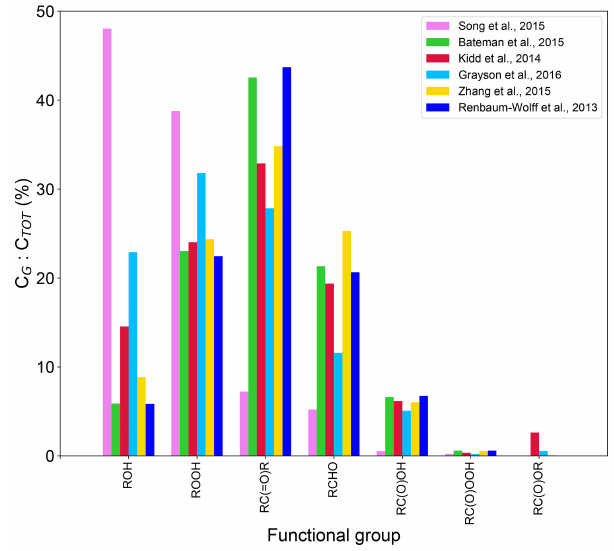
Figure 5. Simulated functional group distributions in particle-phase compounds derived from isoprene photooxidation (Song et al., 2015) and α -pinene ozonolysis (Bateman et al., 2015; Kidd et al., 2014; Grayson et al., 2016; Zhang et al., 2015; Renbaum-Wolff et al.,